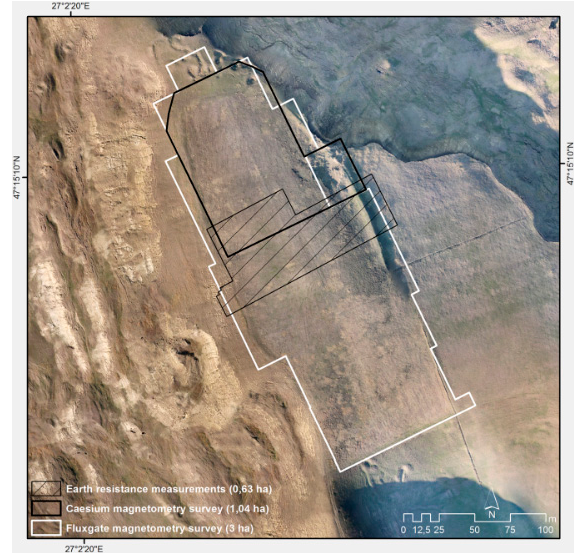
Figure 5. Areas surveyed by means of geophysical techniques.